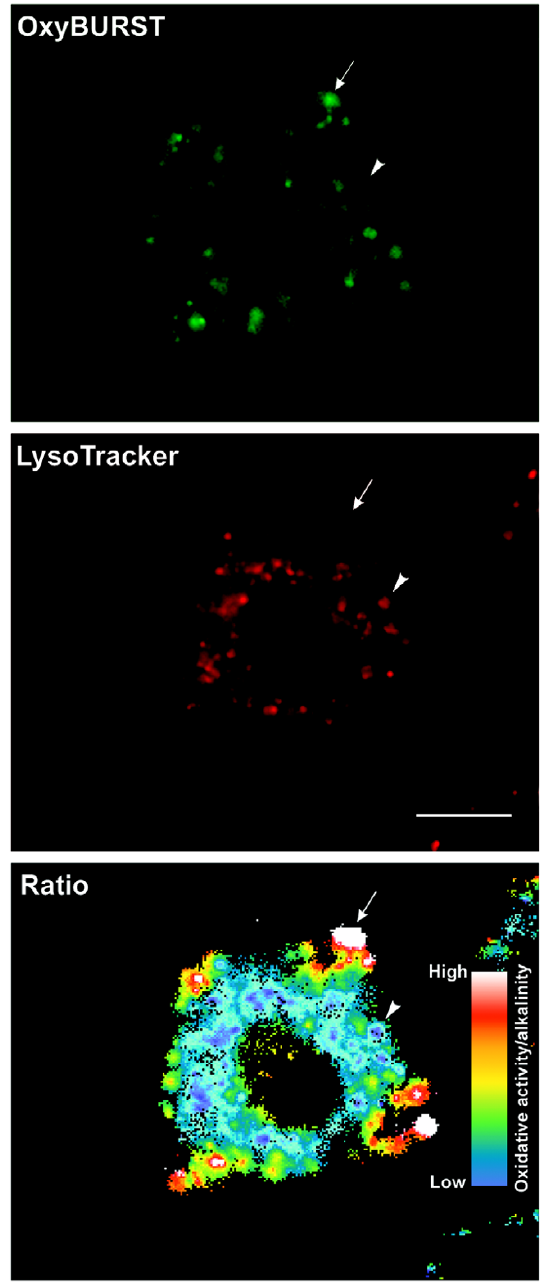
Figure 6 Oxidative activity is high in lysosomes that are weakly stained by the acidotropic dye LysoTracker Red DND- 99. Cell monolayers were incubated with 200 µ g/mL OxyBURST Green H 2 HFF BSA at 37 ° C for 2 hours, washed, and then incubated in the fresh medium containing 200 nM PMA at 37 ° C for 0.5 hour. Cell monolayers were washed and then incubated with 25 nM LysoTracker Red DND-99, at 37 ° C for 10 min, to label acidic lysosomes. As indicated in the two upper panels, high OxyBURST fluorescent intensity and thus high oxidative activity are observed in a subset of lysosomes which contain weak fluorescence with the LysoTracker Red and hence low acidity (indicated by arrows). On the other hand, lysosomes strongly stained by the LysoTracker Red only exhibit lower oxidative activities (see arrowheads). The lower panel is the result- ing ratio image of the OxyBURST over LysoTracker Red fluorescent intensities, which represents the spatial distribution of an arbitrary oxidative activity/alkalinity ratio in the same cell. Bar, 10 µ